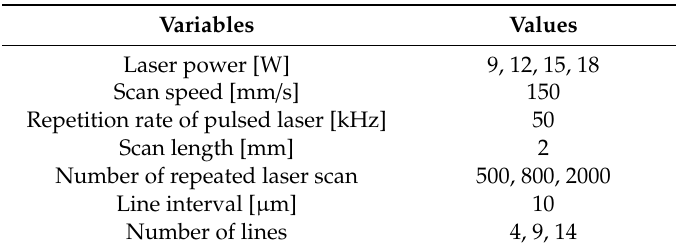
Table 1. Laser parameters for LIBWE.